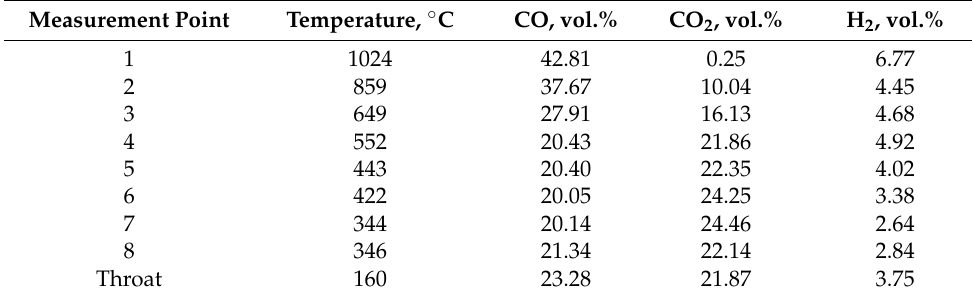
Table 1. Gas characteristics at the BBP and throat levels.